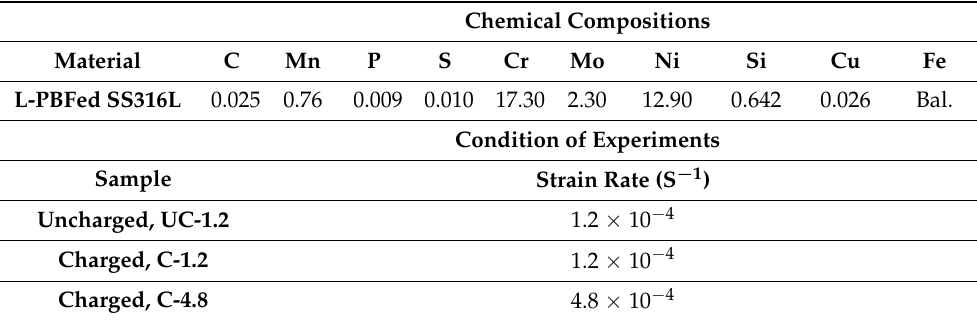
Table 1. Chemical compositions of bulk L-PBFed austenitic stainless steel (ASS) 316L in conjunction with conditions of different experiments in this study.